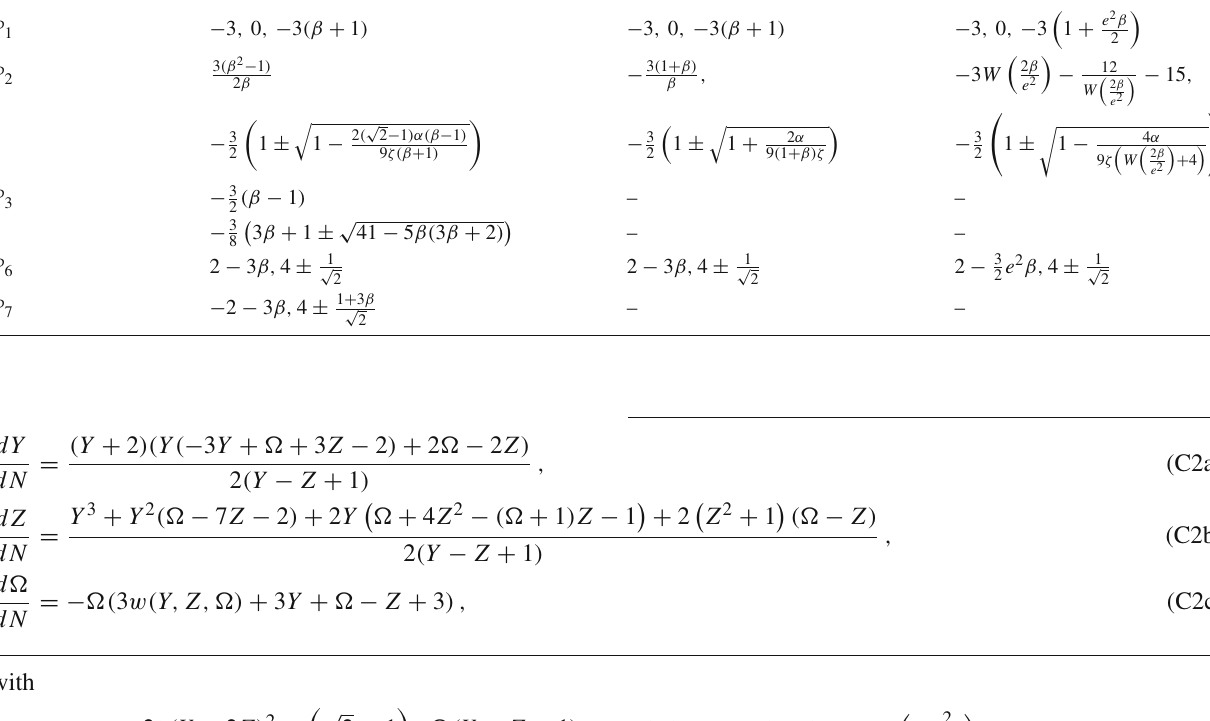
Table 5 Eigenvalues of the Jacobian at the finite fixed points for the dynamical system (23) and presented in Table 1. We remark that the correct physical interpretation of these results require α, ζ > 0, whilst the restrictions on the parameters β can be found in Table 2 Fixed points Redlich–Kwong (Modified) Berthelot